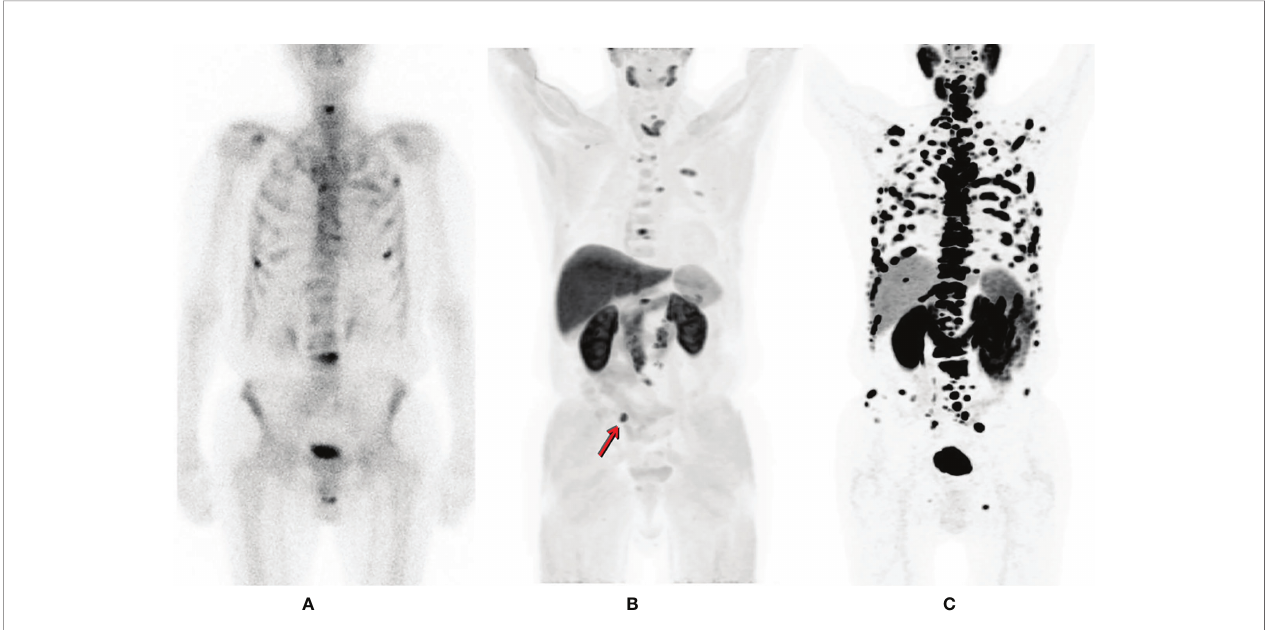
FIGURE 1 | Patient suffering from prostate cancer is referred for bone scintigraphy after biochemical failure, detecting multiple sites of osteoblastic activity corresponding to multiple bone lesions (A) . Within one week the patient also underwent a 11C-Choline PET/CT in order to exclude visceral spread (B) for treatment planning. Apart from additional bone secondaries, a common iliac lymph nodal lesion right (arrow) is detected (maximum intensity projection (MIP); (B) . However, the true spread of the disease is much more extended by 68Ga-PSMA PET (MIP); (C) [republished with permission of the Hellenic Journal of Nuclear Medicine